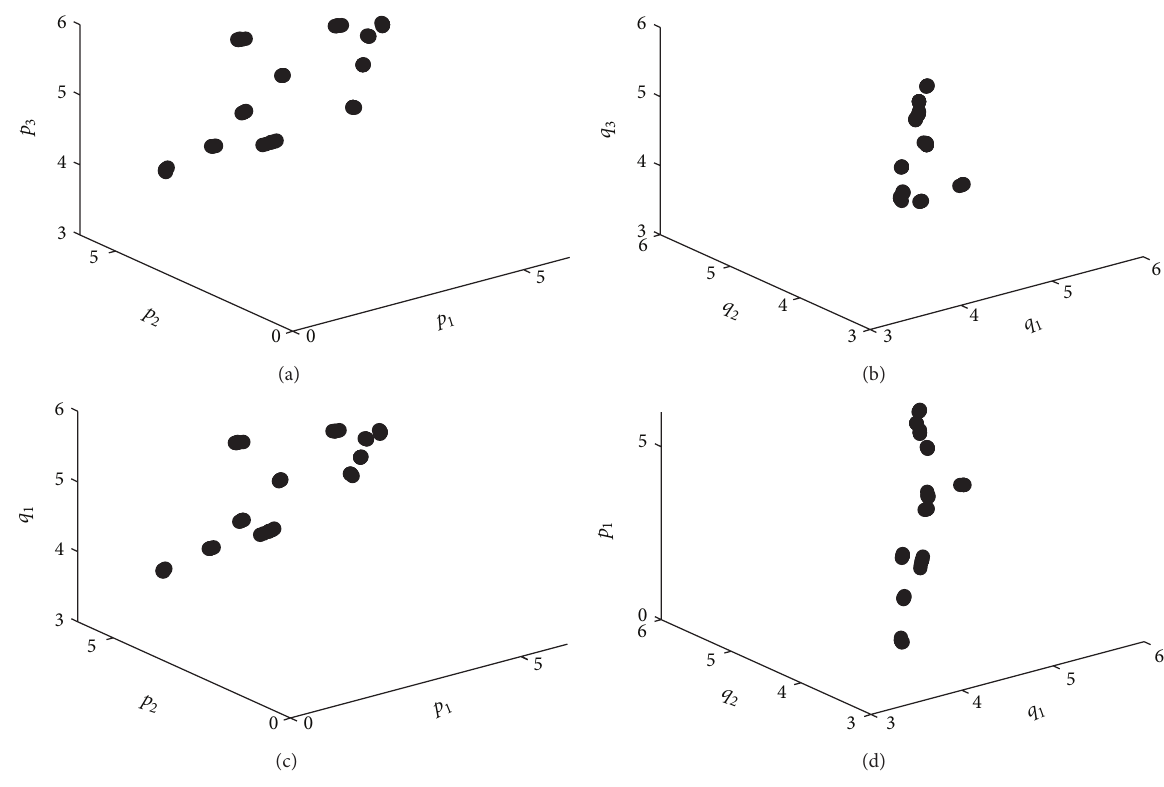
Figure 7: Chaos attractor of the system.